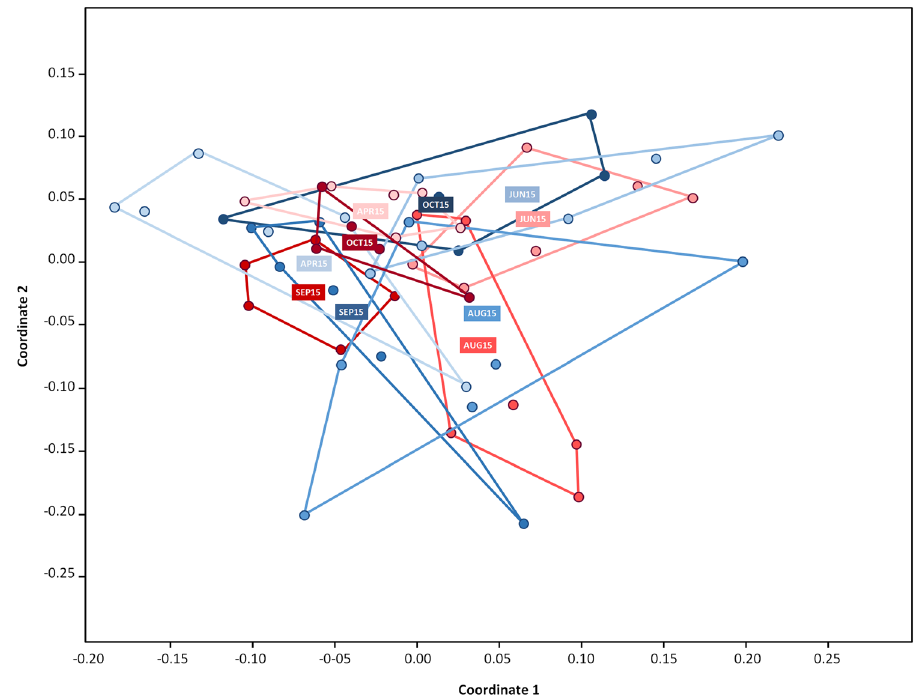
Figure 2. Clustering analysis bacterial composition. Two-dimensional NMDS ordinations clustering the bacterial community structures of the six MR and six MS colonies for each of the five sampling occasions. Analysis of similarity (ANOSIM) revealed statistically distinct ( P = 0.0001) communities of bacteria for the different sampling occasions, but with overlapping structures for the MR (red) and MS (blue) colonies at each sampling occasion (increasingly darker shades of colour from April to October).